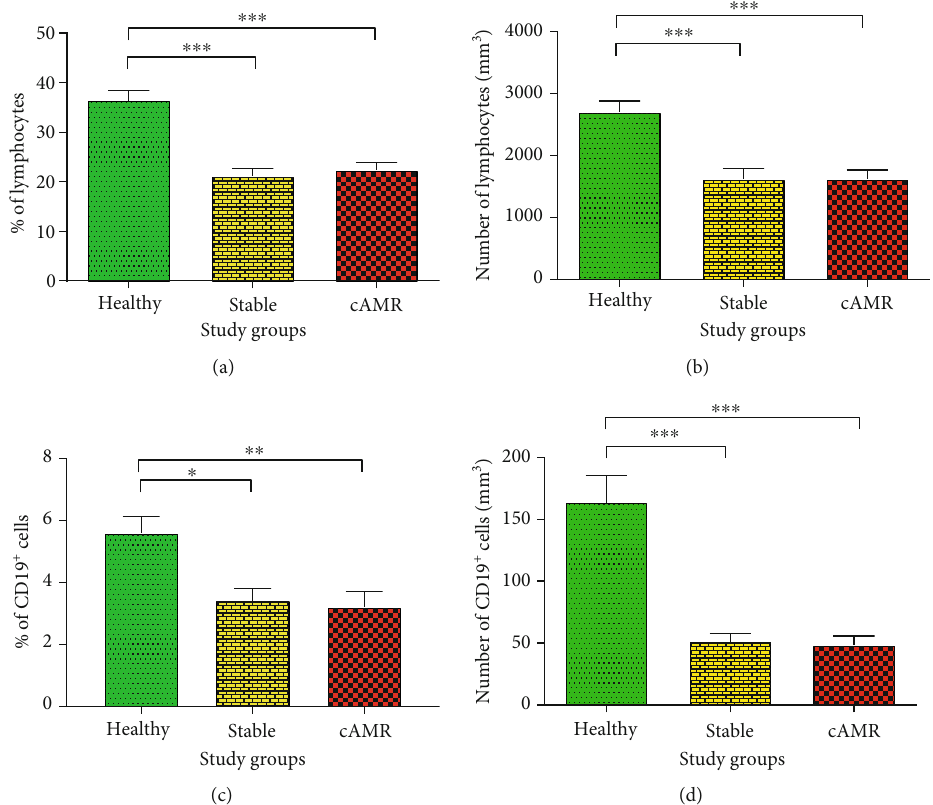
Figure 4: Percentage (a) and absolute number (b) of lymphocytes, as well as percentage (c) and absolute number (d) of CD19 + B cells in healthy individuals, patients with stable graft function, and cAMR patients ( ∗ P ≤ 0 : 05 , ∗∗ P ≤ 0 : 01 , ∗∗∗ P ≤ 0 : 001